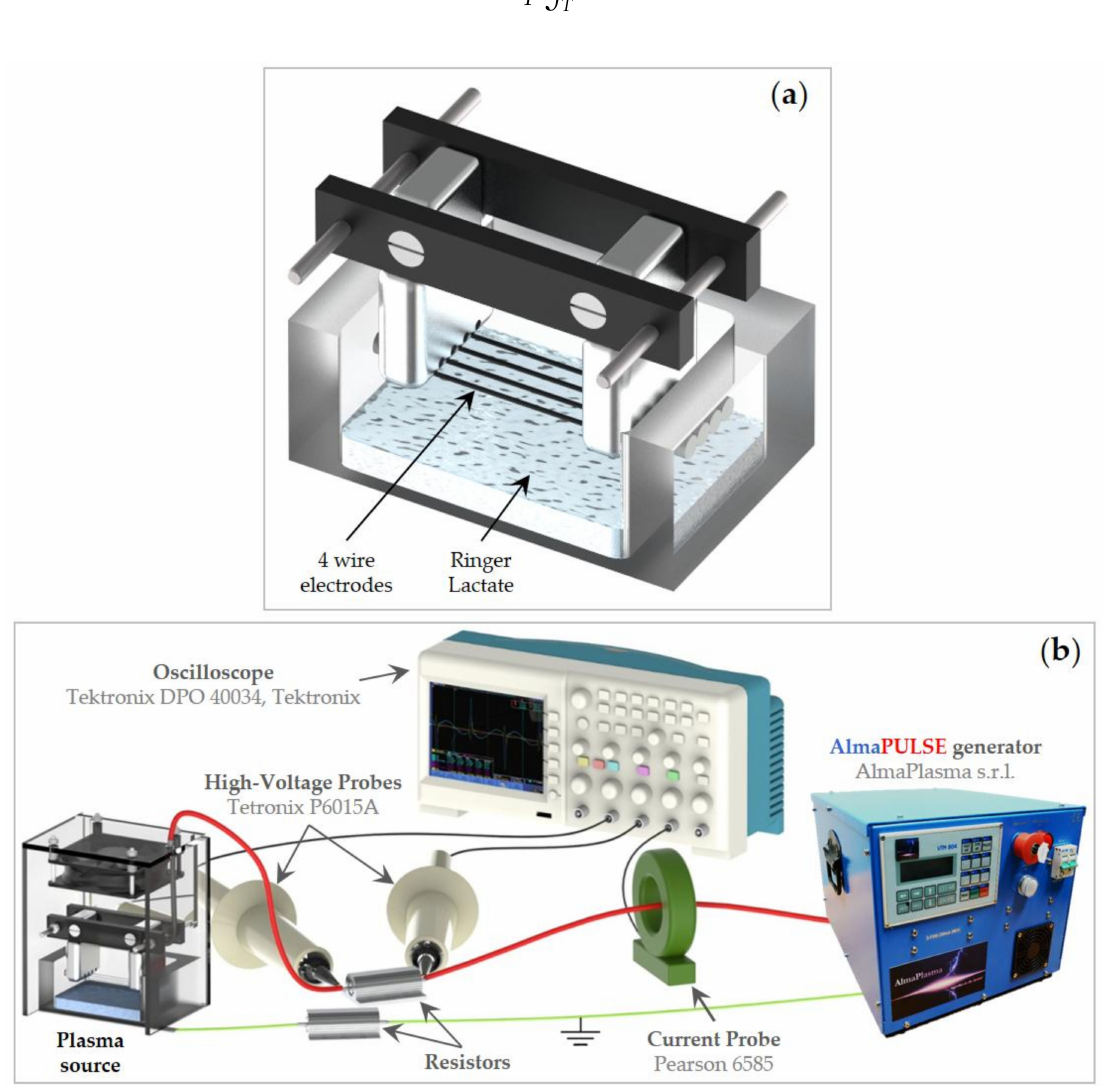
Figure 7. ( a ) Illustration of the high voltage electrodes and RL and ( b ) layout of the setup used for electrical